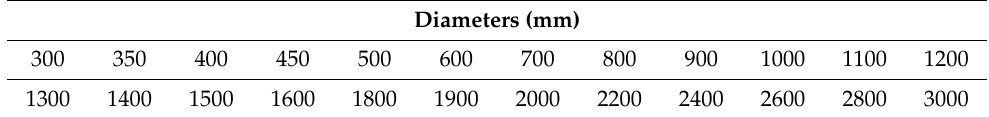
Table 5. Complete range of diameters